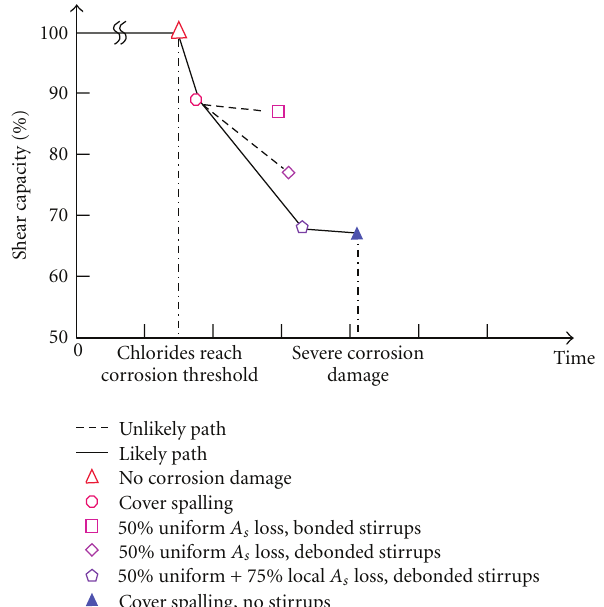
Figure 16: Corrosion damage sequence as a function of shear